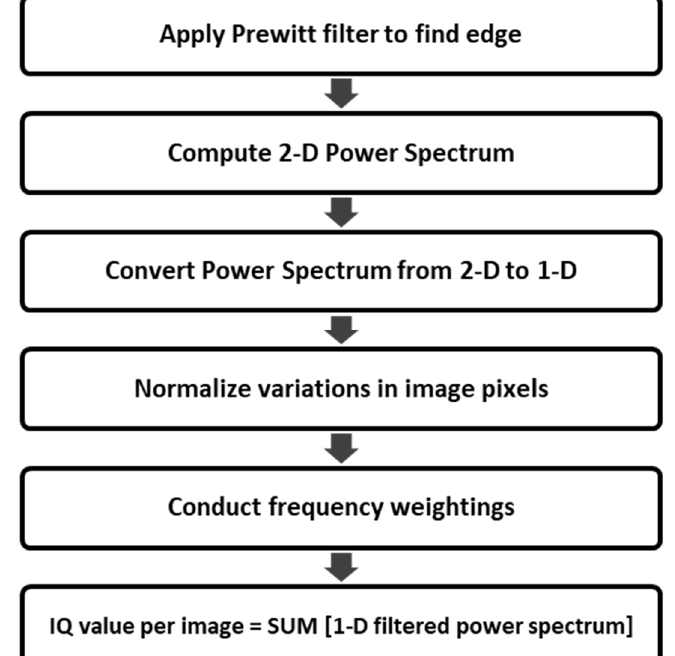
Figure 2. The Proposed FIQA process.